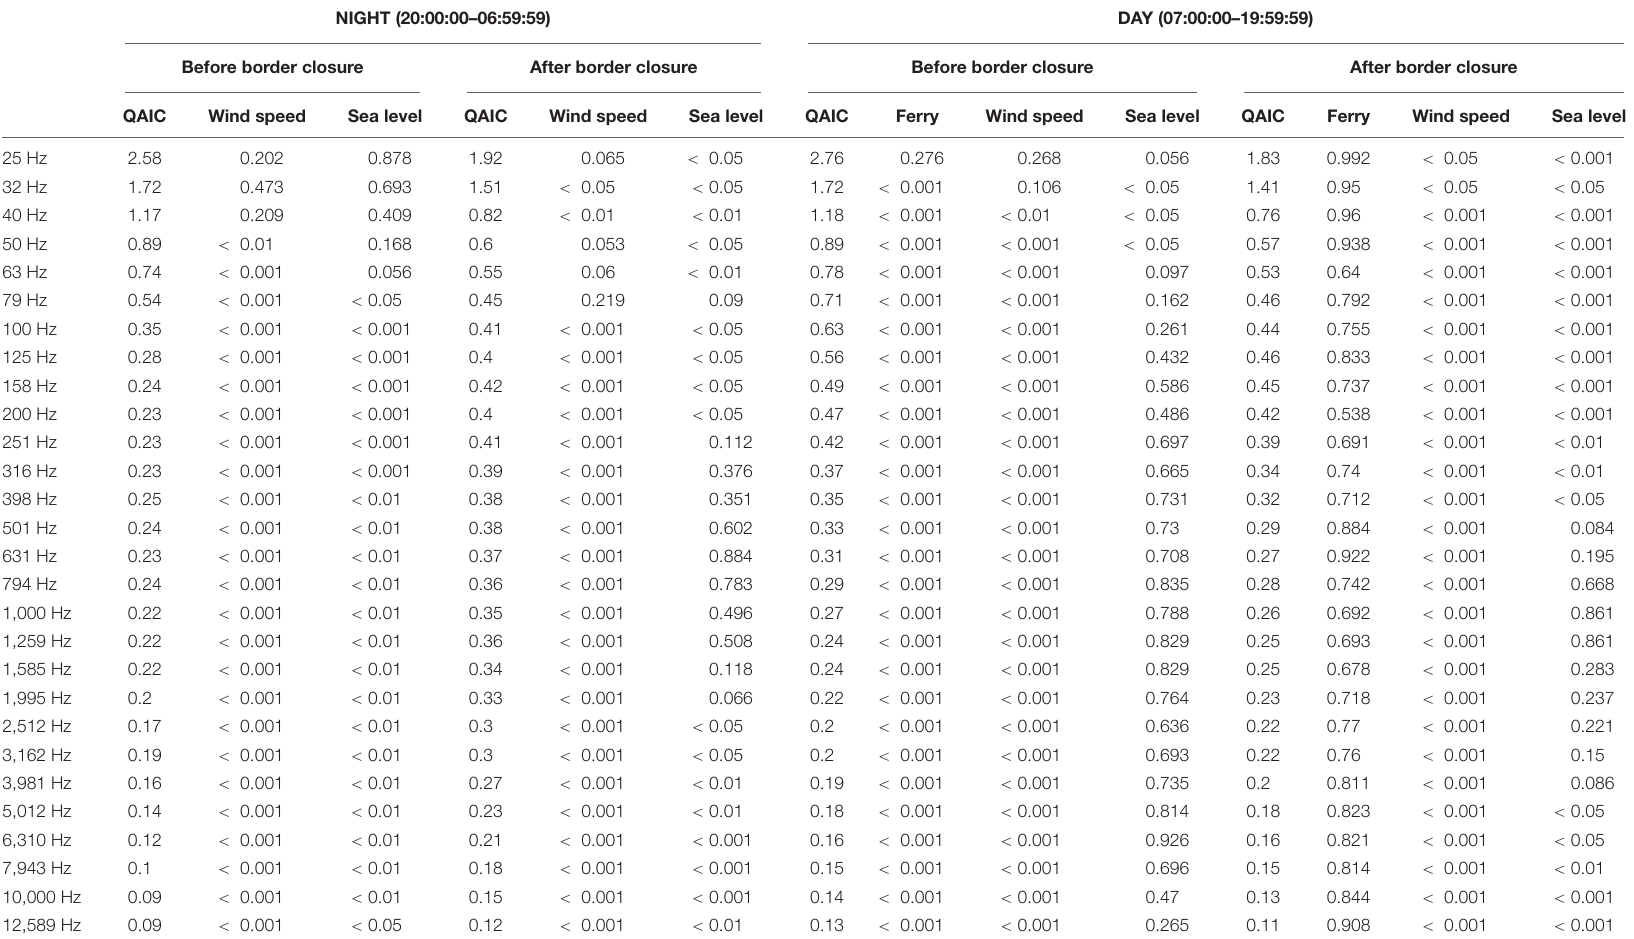
TABLE 4 | Table showing goodness of fit (QAIC) and the statistical significance ( p -values) of the GLM regression analyses of day and nighttime noise levels before (29 January–14 March 2020) and after border closure (15 March–26 May 2020), accounting for the predictor variables ferry, wind speed (m/s), and sea level height